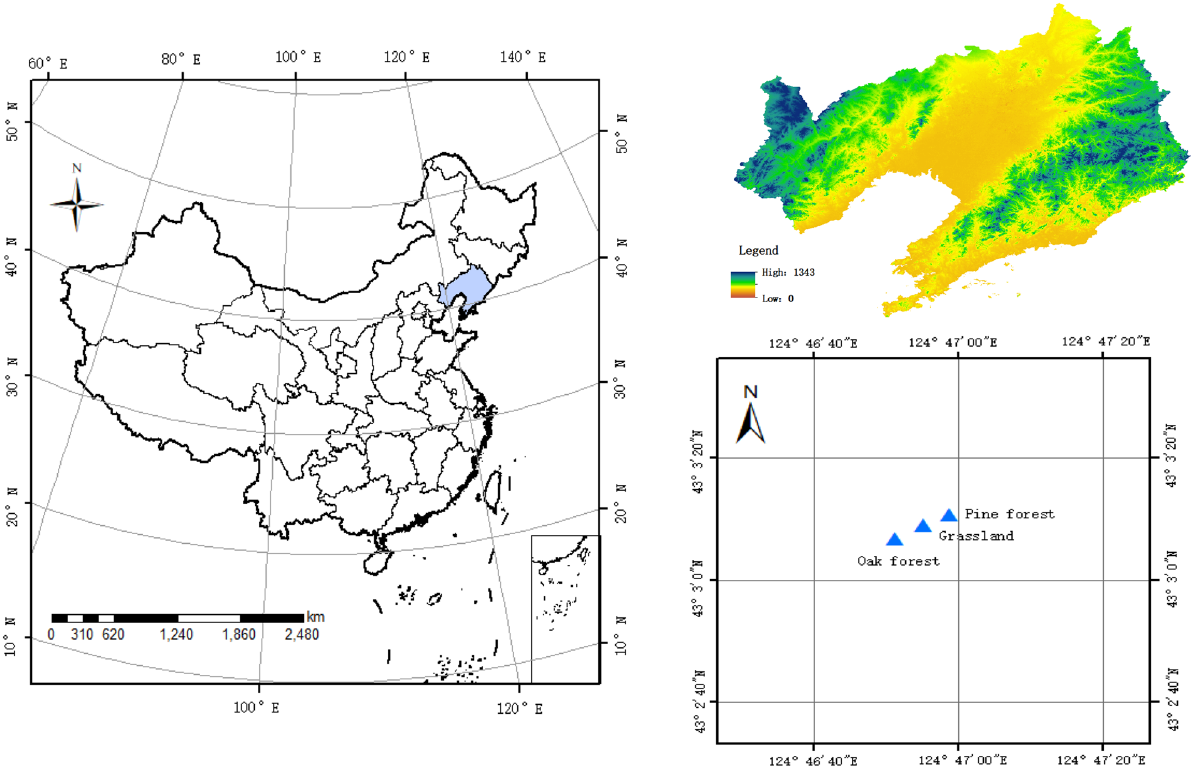
Figure 1. Distribution map of three experimental sites for different vegetation type (forestland, cropland, and abandoned land) in Liaoning province in northeast China. (Map created using ArcGIS 10.6 software by first author, URL: http:// www. esri.